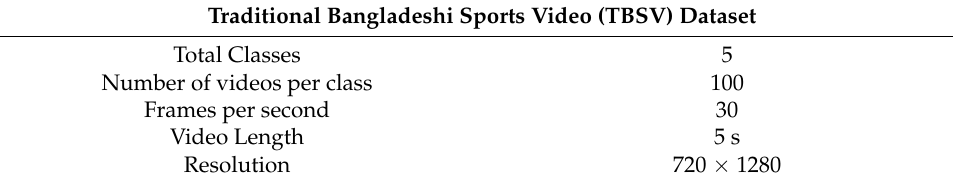
Table 1. TBSV dataset details.